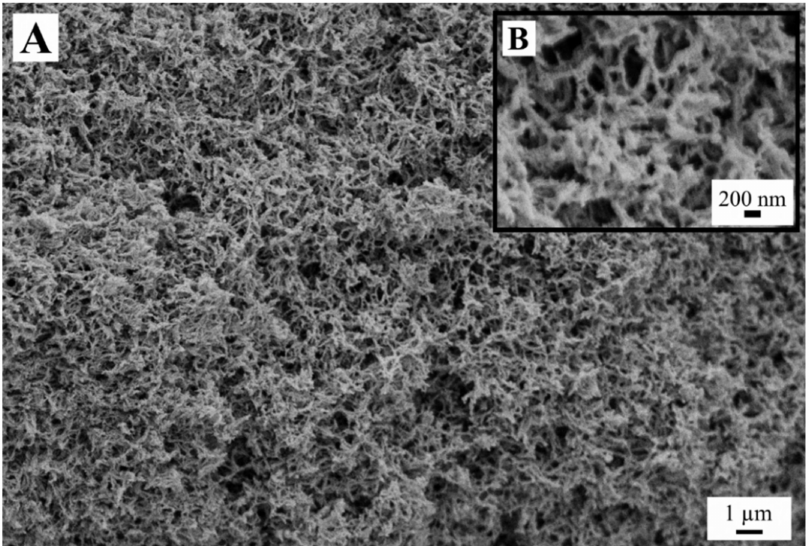
Figure 9. Structure of the starch aerogel (SCD-G) derived from 10 wt.% starch suspension. Picture ( A ) shows an overview of the material which fine structure is displayed with a higher magnification on picture ( B